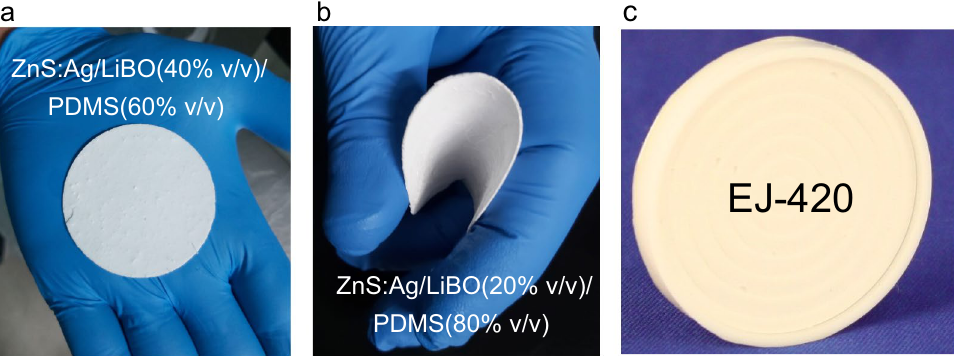
Figure 4. Pictures of two samples of the LiBO/ZnS:Ag-based scintillators produced ( a ) ZnS:Ag/LiBO (3:1) (40% v/v)/PDMS and ( b ) ZnS:Ag/LiBO (3:1) (20% v/v)/PDMS. ( c ) Commercial EJ-420 thermal neutron detector.